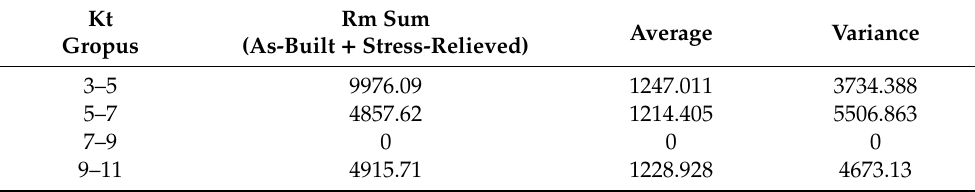
Table A6. Input data for ANOVA: Single Factor